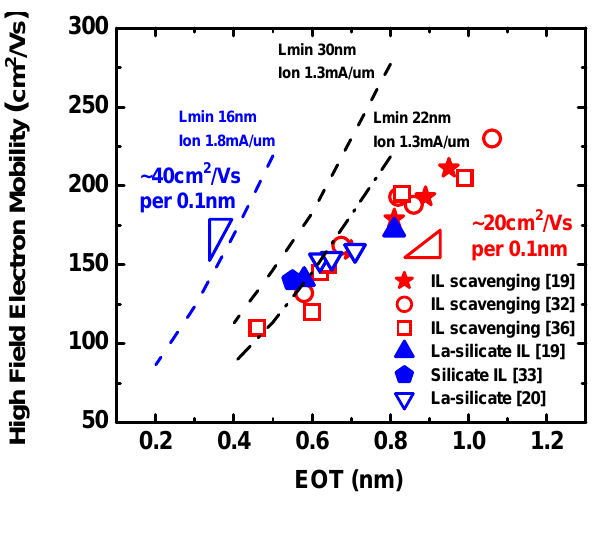
Figure 11. High field electron mobility as a function of EOT from literature data including remote IL scavenging [19,36], direct IL scavenging using Hf [32], La-silicate IL with HfO [19,33], and single-layer La-silicate [20]. The mobility values are taken at 2 N = 1 × 10 13 cm − 2 in [36] and at E = 1 MV/cm in all other work. Simulated contour inv eff lines providing the same I at L 16, 22, and 30 nm are shown for comparison on min (after